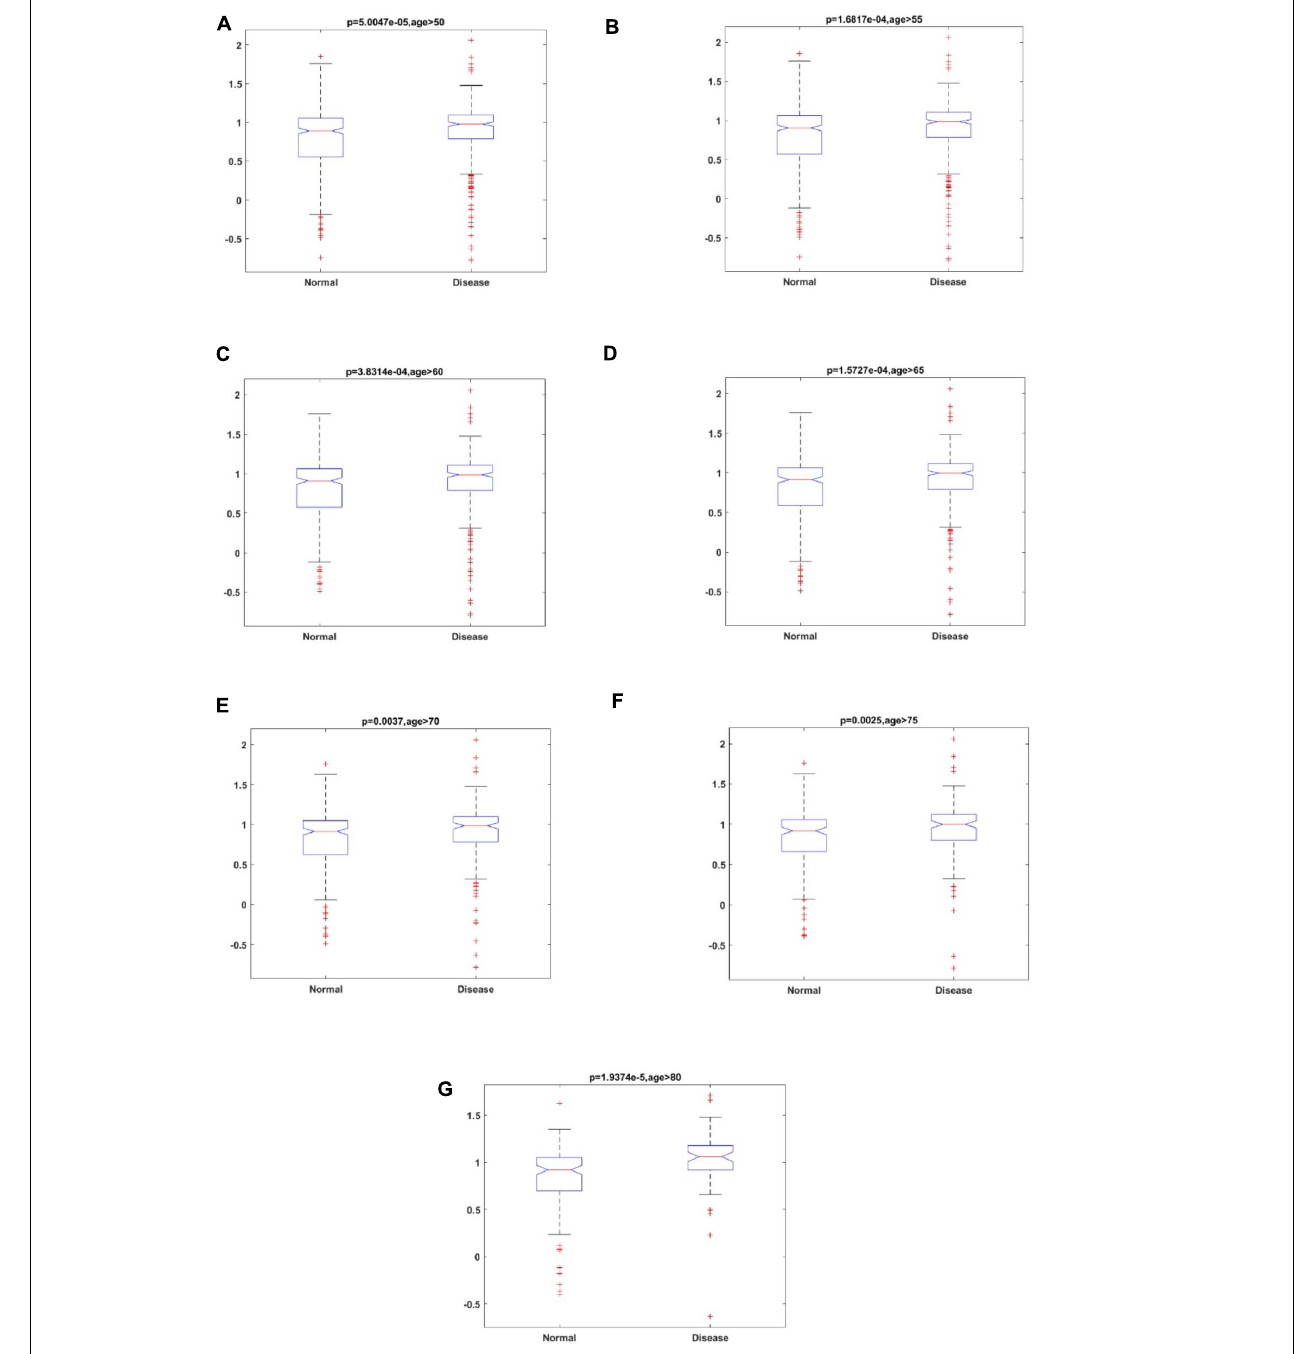
FIGURE 3 | The results of the Kruskal–Wallis test for aging scores of ND individuals and normal individuals in different age groups. (A) Age ≥ 50; (B) Age ≥ 55; (C) Age ≥ 60; (D) Age ≥ 65; (E) Age ≥ 70; (F) Age ≥ 75; and (G) Age ≥ 80.